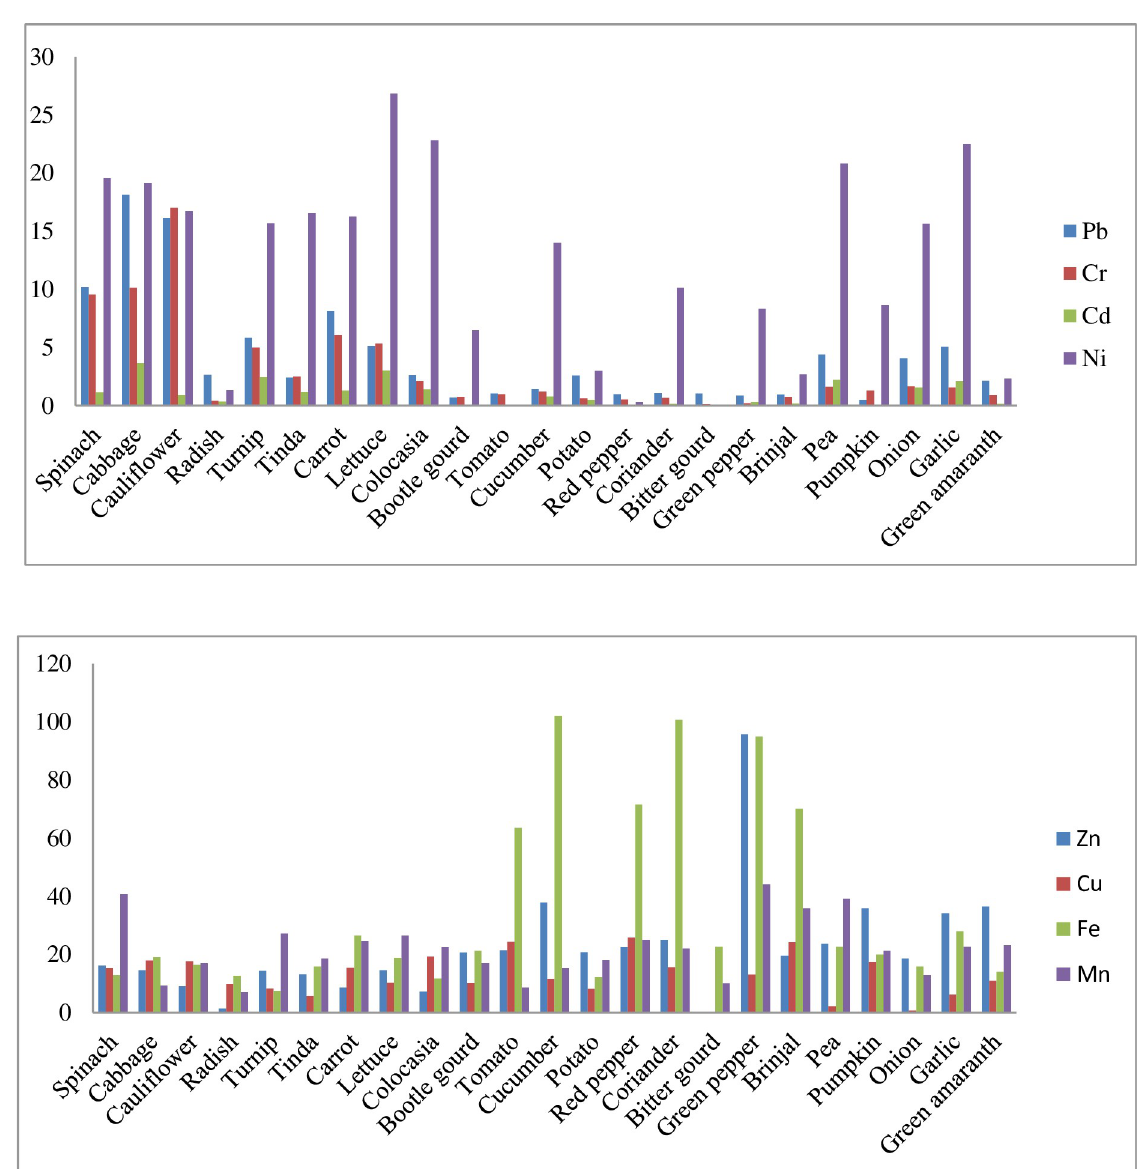
Fig 2. Heavy metals concentration in vegetables of